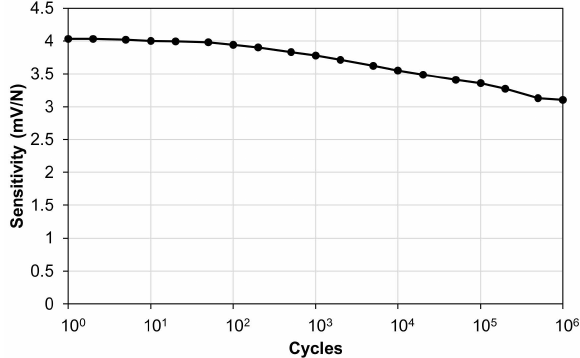
Figure 13. Piezoelectric sensor fatigue test.